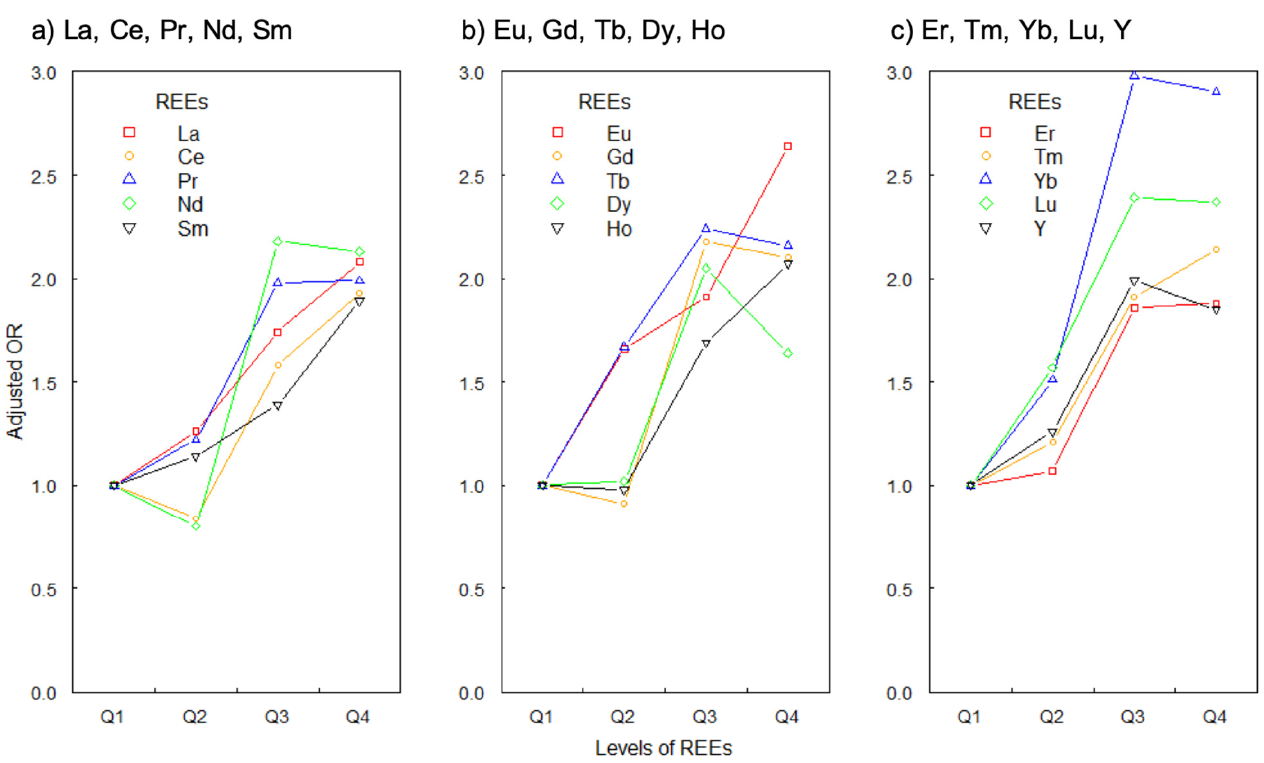
Figure 1. The adjusted ORs of 15 REEs in quartile intervals and their linear trends. ( a – c ) jointly showed significant linear trends of 15 REEs’ adjusted ORs (all the p -trend values were <